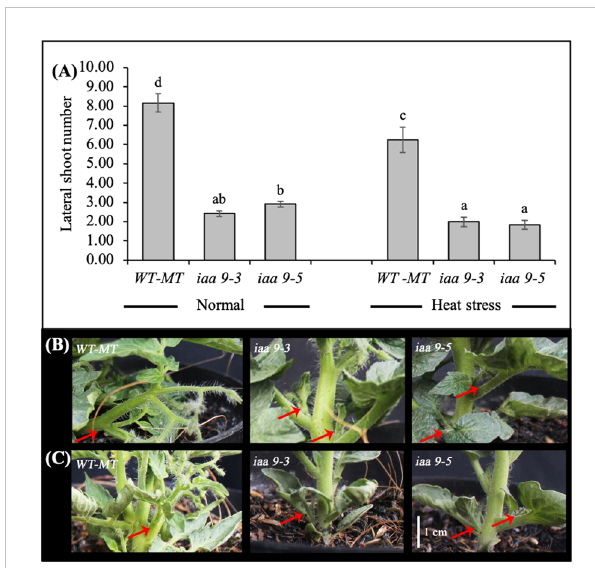
FIGURE 2 (A) The average value of lateral shoot number of WT-MT, iaa9-3 and iaa9-5 under two temperature conditions. The lateral shoot number of WT-MT, iaa9-3 and iaa9-5 under (B) normal temperature and (C) heat stress condition. The average value ± standard error (SE) (n = 4) followed by the same lowercase letters is not signi fi cantly different based on Duncan ’ s Multiple Range Test at 5%.